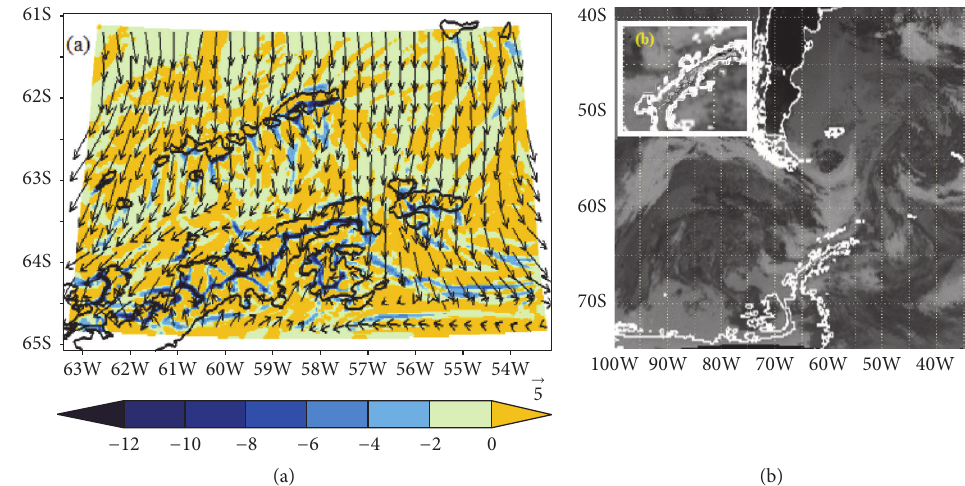
Figure 7: The same as in Figure 6, but for 24 December 2013, model output at 19:00 UTC and satellite image at 17:45 UTC.